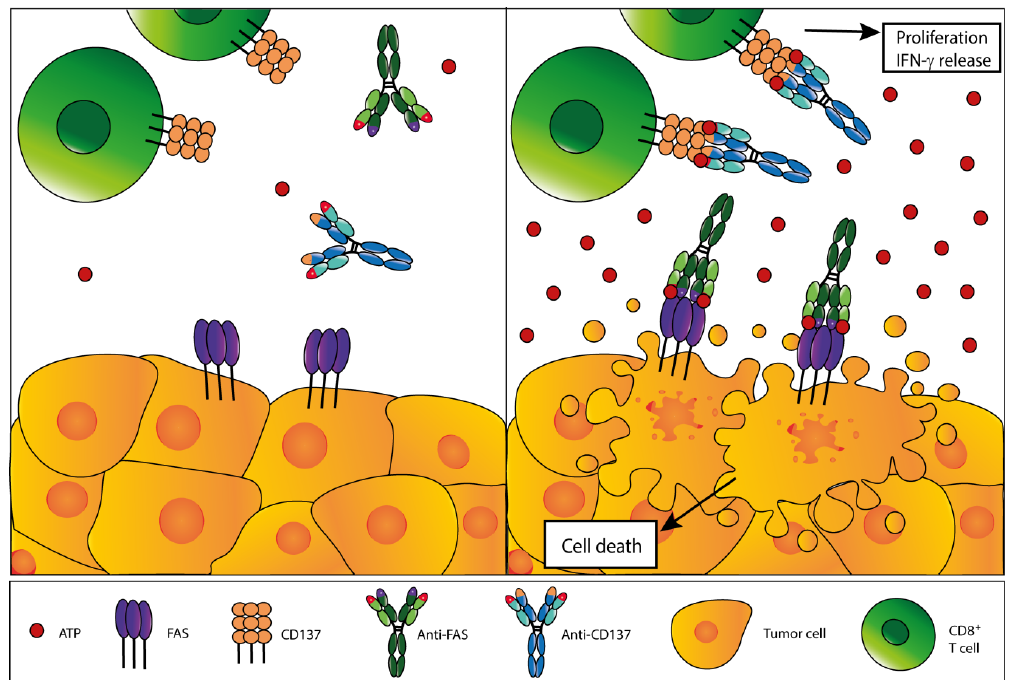
Figure 4. Strategies to exploit the elevated eATP concentration in the TME for antitumor therapy. A novel anti-CD137 monoclonal antibody was generated by Igawa and co-workers [171] that binds the antigen only in the presence of ATP levels close to those found in the TME ( left panel ). Under these conditions, and only under these conditions, this antibody binds and activates the costimulatory receptor CD137 expressed by CD8 + T cells, thus promoting T cell proliferation and cytokines release (e.g., IFN- γ ), which boosts antitumor immune response ( right panel ). In the same way, we can hypothesize the engineering of an antibody that binds and activates suicide receptors on tumor cells, such as the FAS receptor, that is selectively activated by high ATP in the TME ( right panel